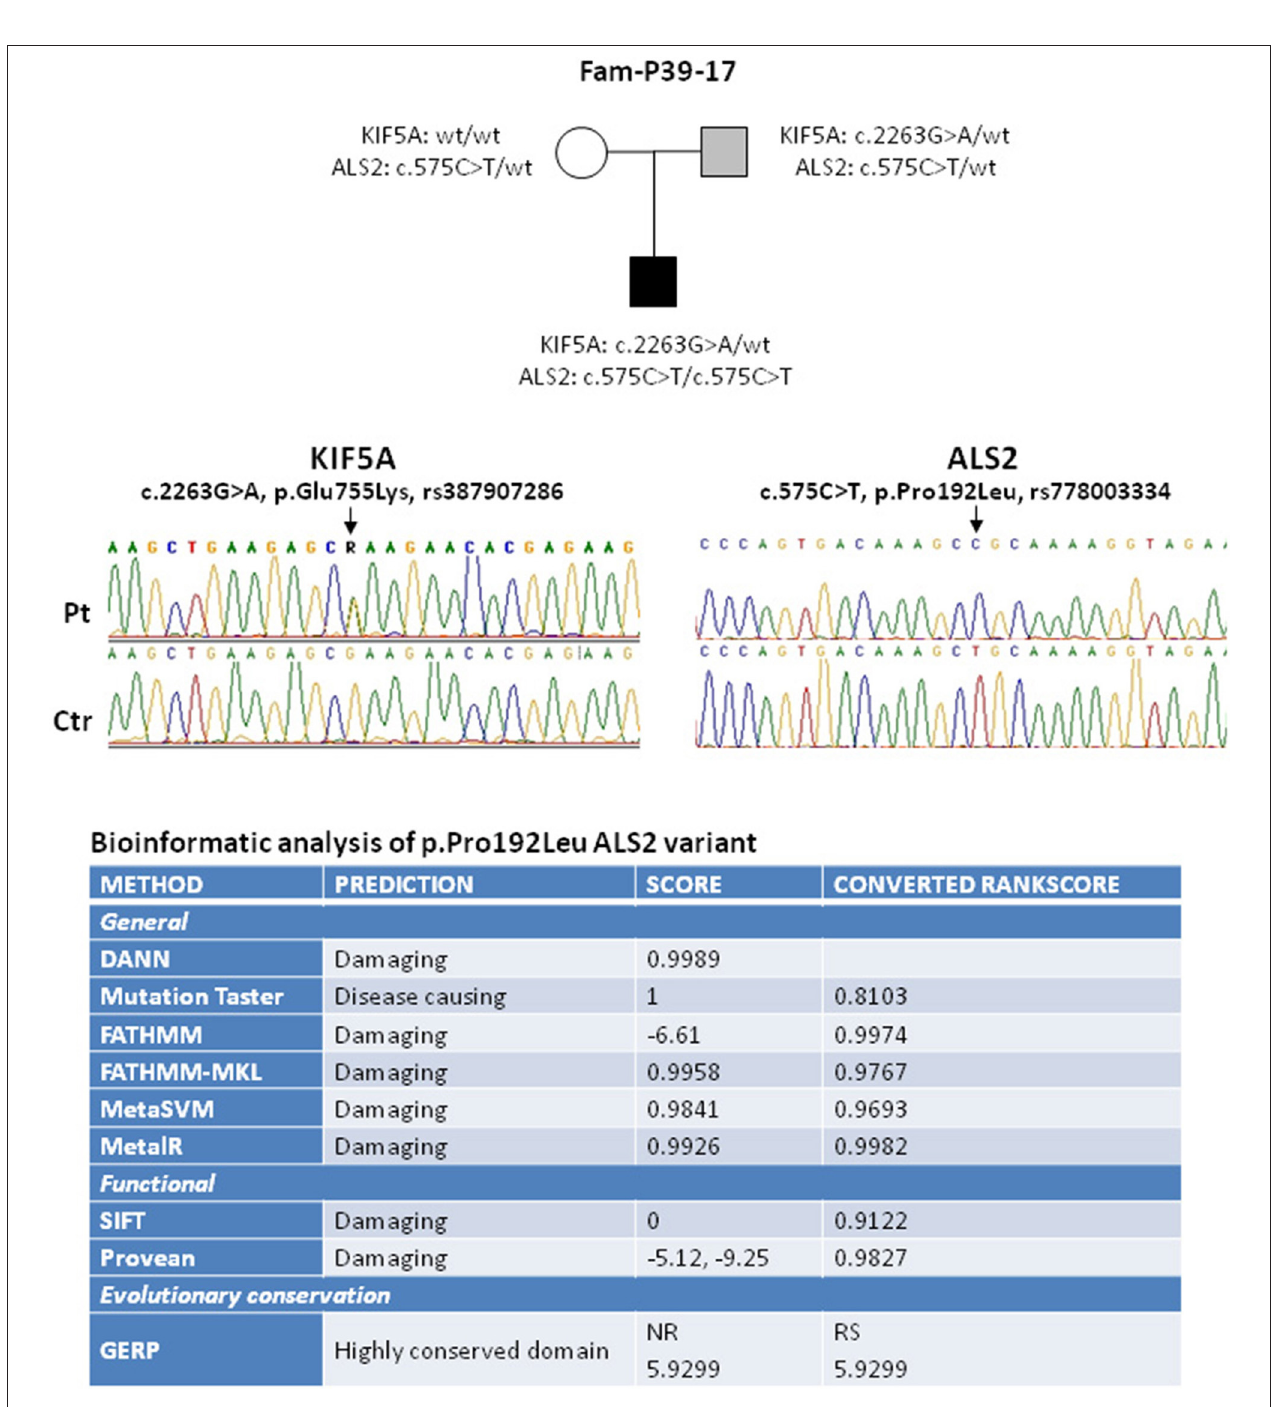
FIGURE 1 | Elechtropherograms of the variants in KIF5A and ALS2 identified in the proband and his family. In the upper panel the black box indicates the proband affected by the juvenile onset of ALS while the light gray box indicates the mild ALS clinical phenotype of the proband father. A summary of the bioinformatic analysis results of the ALS2 variant is reported in the bottom part. As listed in the figure, the software used provide prediction of negative effects at the general and functional level. GERP Software provide information about the evolutionary conservation of the substituted amino acid residue.